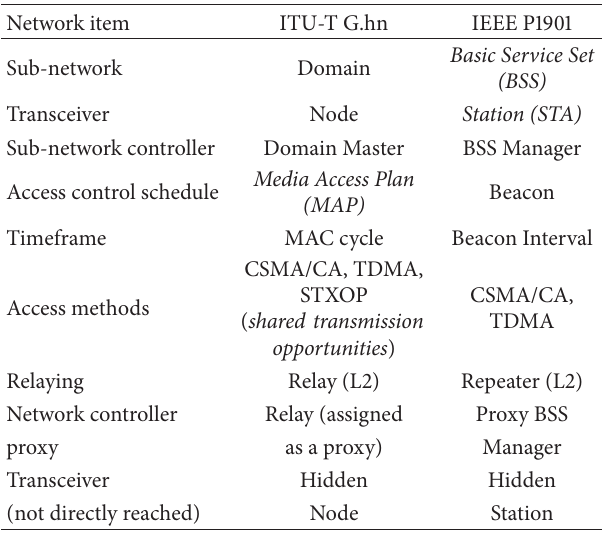
Table 5: Synopsis of terms used in the BB-PLC standards ITU-T G.hn and IEEE 1901 [75] © 2012 John Wiley &